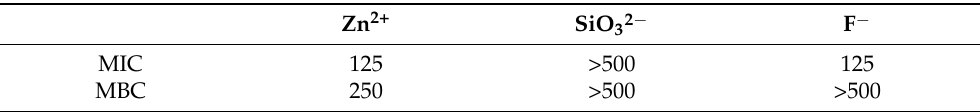
Table 2. Minimum inhibitory concentrations (MICs) and minimal bactericidal concentrations (MBCs) of Zn 2+ , F − , and SiO 32 − on S. mutans (in